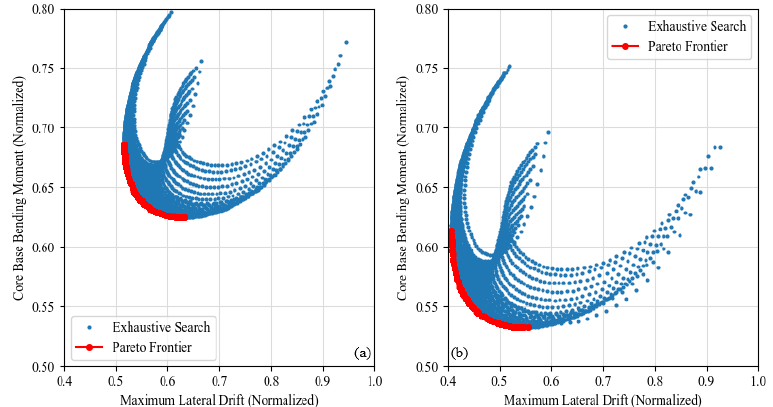
Figure 11. Exhaustive search with (a) 2 ORs (b) 2 ORs-BTs (compared to Pareto frontier obtained in this paper)